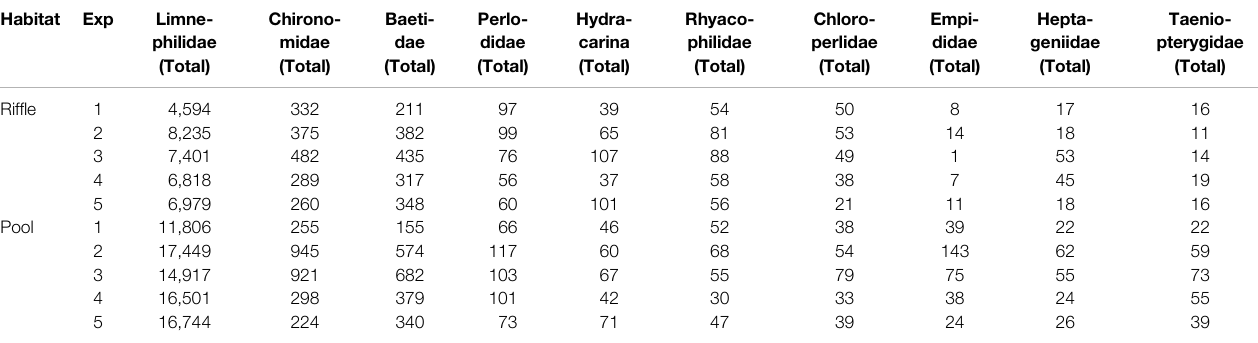
TABLE 4 | Abundance of ten most common drifting macroinvertebrate taxa (in descending order) separated by rif fl e and pool as well as by experiment in the downstream habitats. Habitat